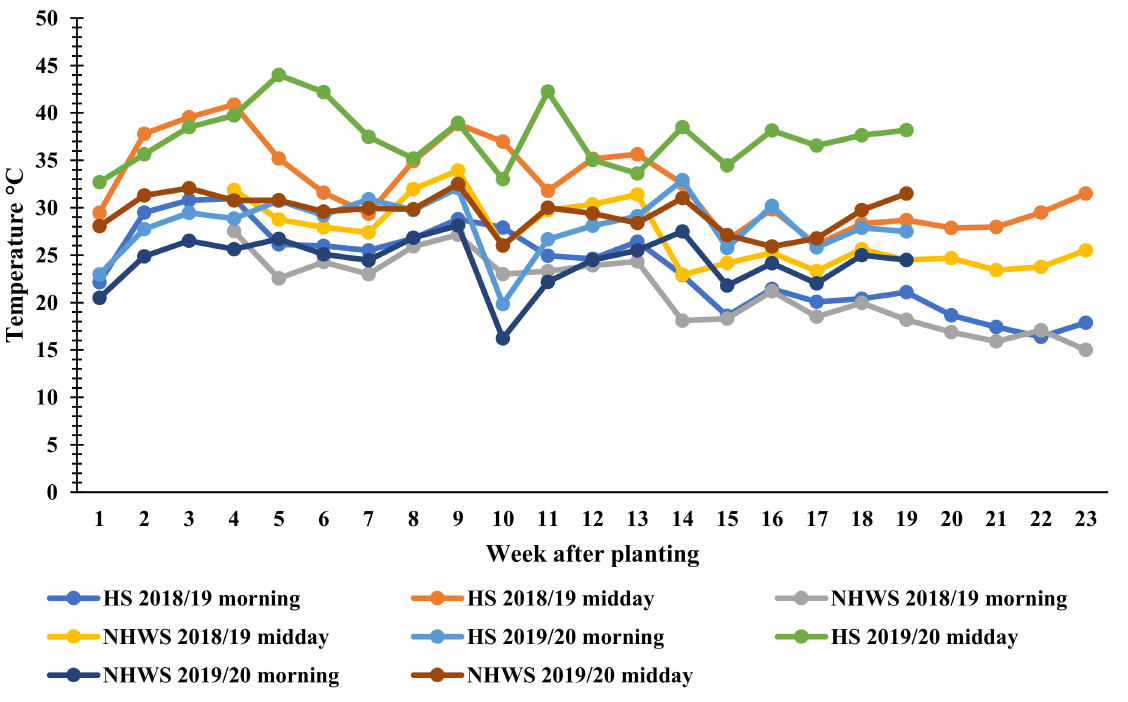
Figure 1. Weekly temperature records for HS and NHWS environments for the two seasons of